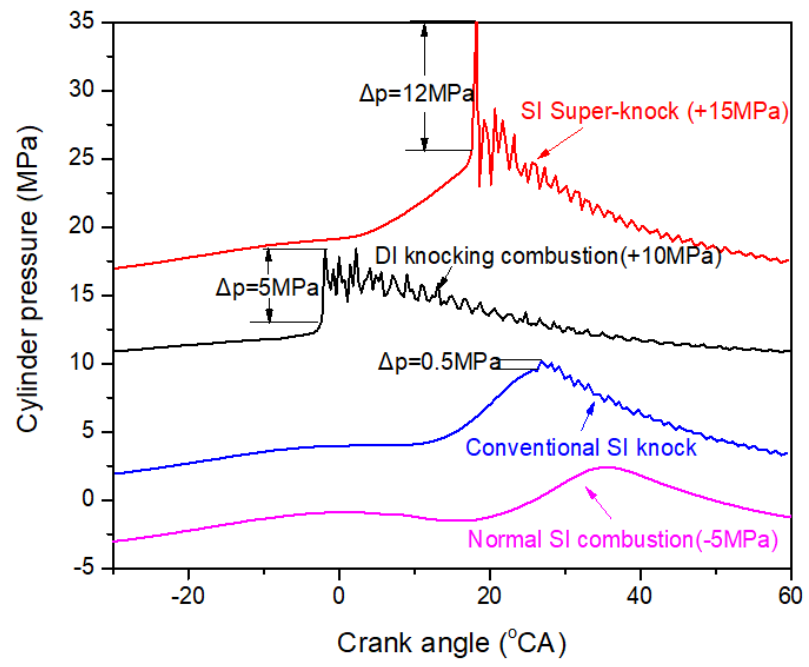
Figure 1. Three typical modes of combustion in boost SI engines (reprinted from [8]) and CI knocking combustion pressures traces.